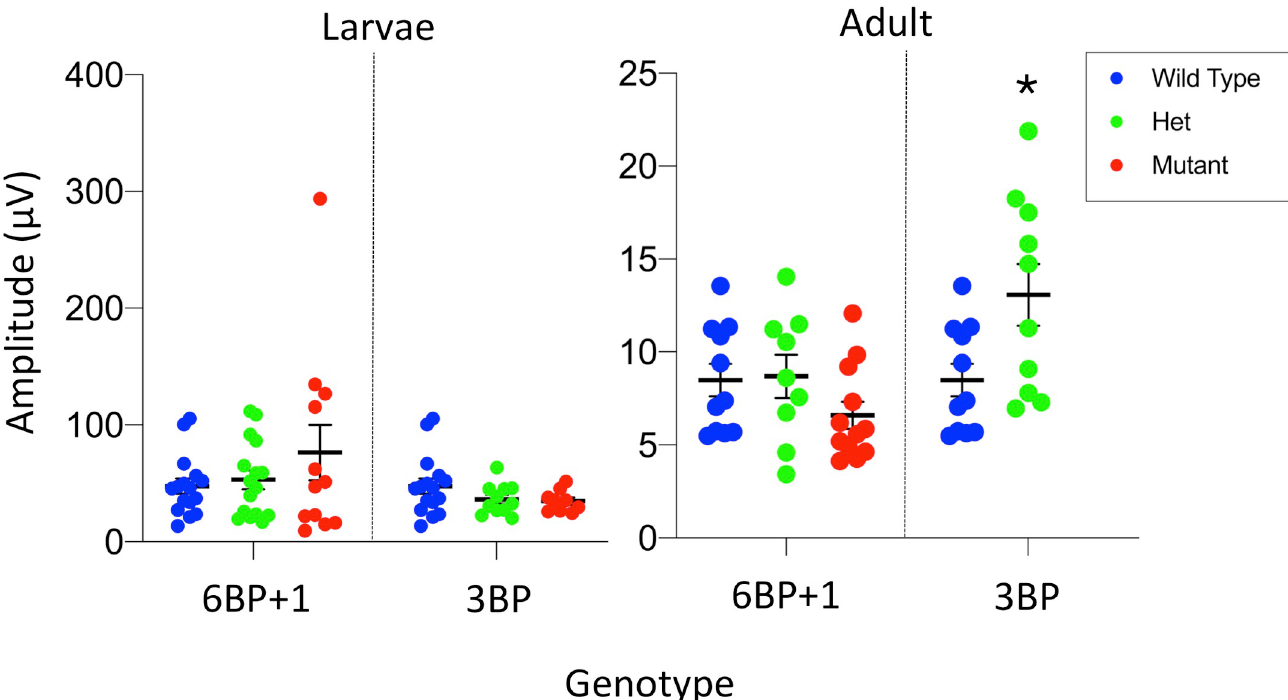
Fig 8. Maximal dataset amplitudes in tr β 2 genetic strains. The maximum cone PIII amplitudes for datasets from each genotype are compared. There is no significant difference between the 6BP+1 5–7 dpf mutants (N = 12), het mutants (N = 16), and WT (N = 17); nor is there a significant difference between the 3BP mutants (N = 17), het mutants (N = 33), and WT (N = 17). The 6BP+1 adult mutants (N = 12), het mutants (N = 9) and WT (N = 11) were not significantly different. There was a significant difference (One-way ANOVA, P = 0.02) between the 3BP adult het mutants (N = 10) and wild types (N = 11). There are no 3BP adult mutants. The wild type groups combine fish from 6BP+1 and 3BP heterozygote in-cross spawns.